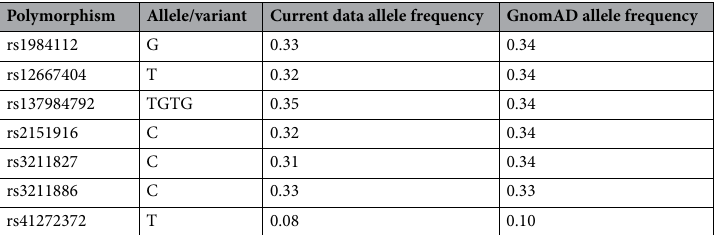
Table 3. Comparisons of allelic frequencies between our study group and the frequencies listed in Genome Aggregation Database (GnomAD 50 ) for the European population.